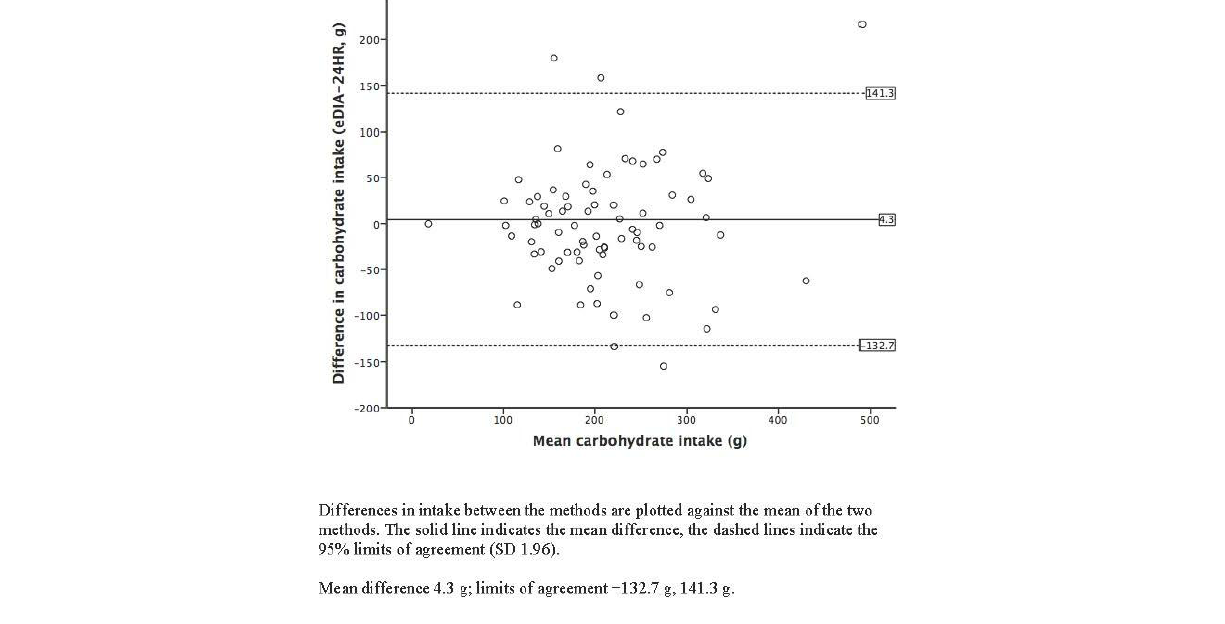
Figure 5. Bland-Altman plot of 24-hour dietary recalls (24HR) and electronic Dietary Intake Assessment (e-DIA) for carbohydrate intake.